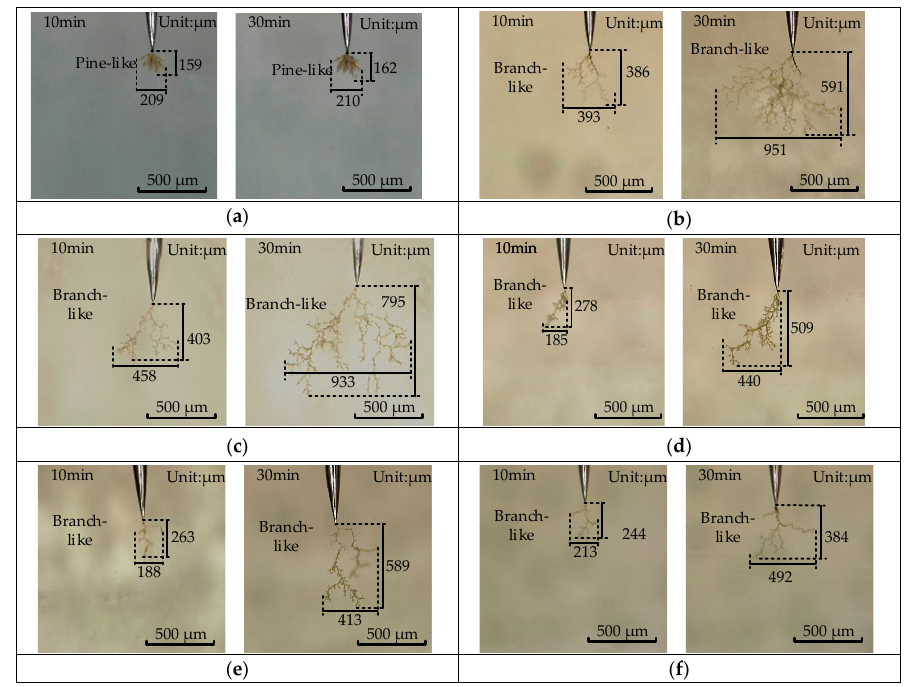
Figure 4. Typical morphology of electrical tree under square wave voltage with different duty cycles. ( a ) 5% duty cycle, ( b ) 10% duty cycle, ( c ) 30% duty cycle, ( d ) 50% duty cycle, ( e ) 70% duty cycle, ( f ) 90% duty cycle.